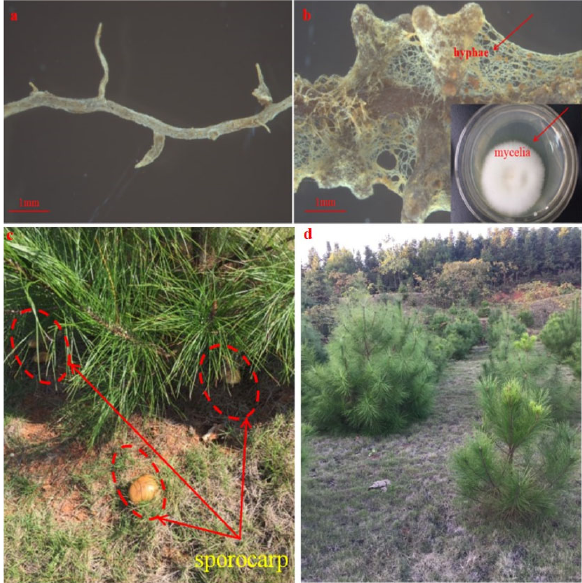
Figure 1. Morphological structures of ( a ) non inoculated fine roots, ( b ) roots inoculated with S. luteus (scale bar = 1 mm), plots with ( c ) inoculated roots, and ( d ) non inoculated (control) plots.